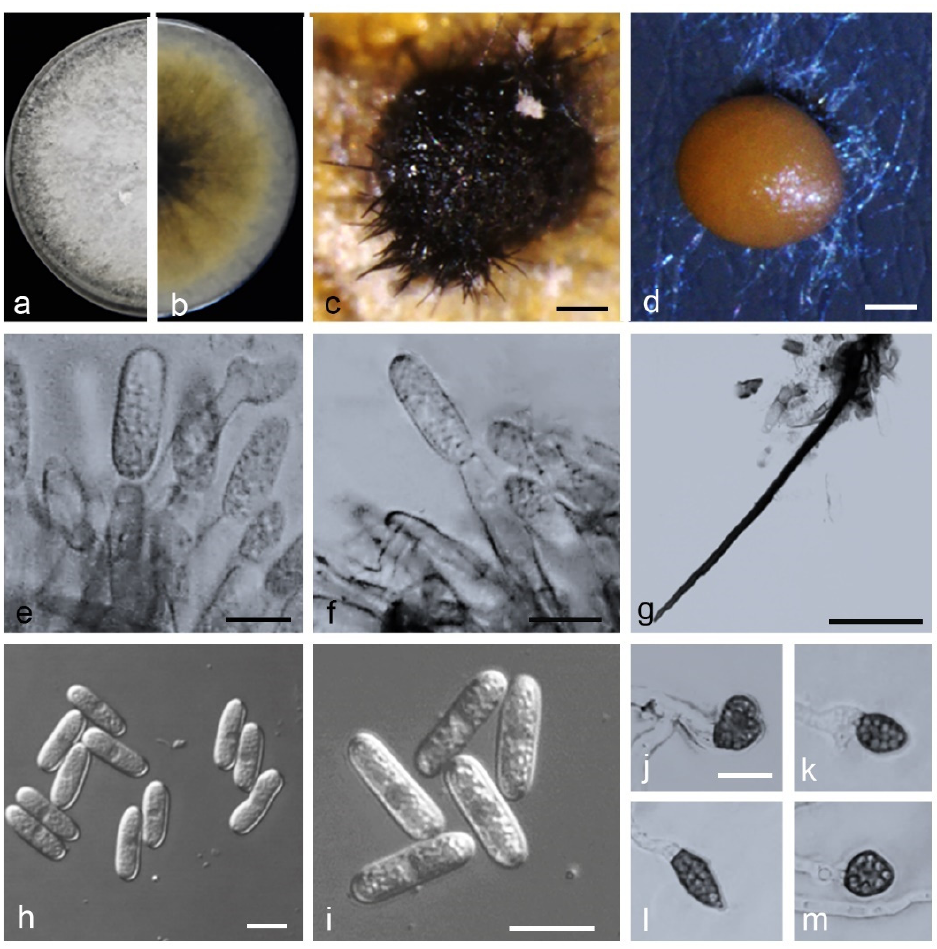
Figure 14. Colletotrichum kaifengense . ( a , b ) Front and back view, respectively, of 9-d-old PDA culture; ( c , d ) conidiomata; ( e , f ) conidiophores; ( g ) seta; ( h , i ) conidia; ( j – m ) appressoria; ( a – m ) isolate CAASZK33; ( a – c , g ) produced on PDA agar medium; ( d – f , h – m ) produced on SNA agar medium). Scale bars: ( c , d ) = 100 μ m; ( g ) = 50 μ m; ( e , f , h – m ) = 10 μ m.